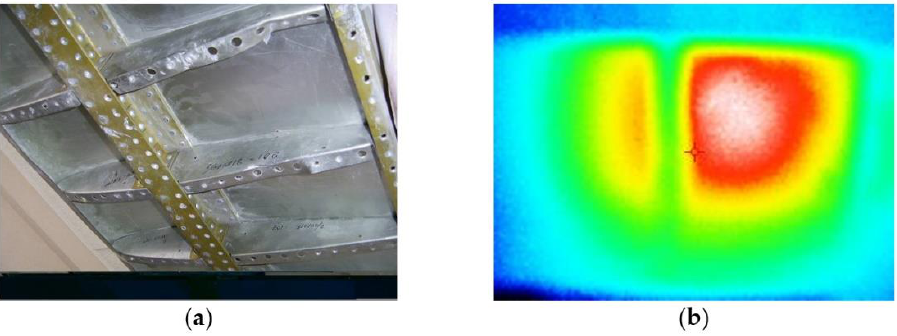
Table 3. Change in the power of the heating system when the thickness of the panel under repair is changed.